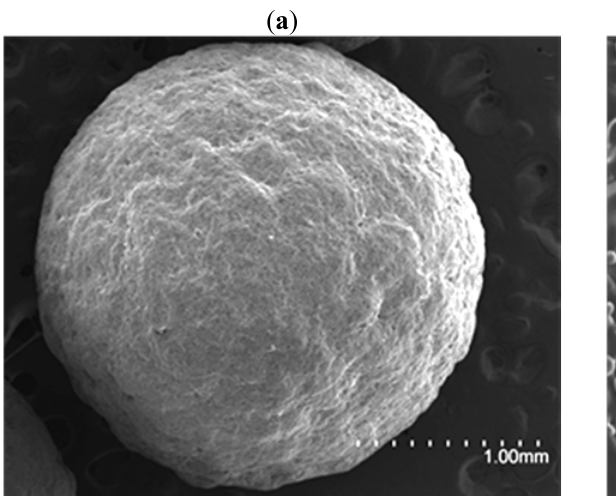
Figure 3. ( a ) Alumina hollow particle; and ( b ) the surface of the alumina particle (Courtesy Oliver M. Strbik III, Deep Springs Technologies, Toledo, OH,